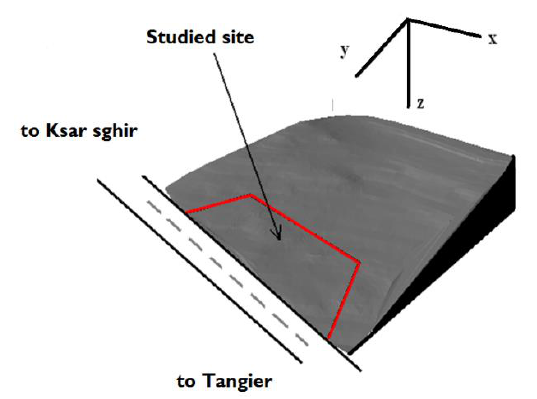
Figure 2. Studied Slope